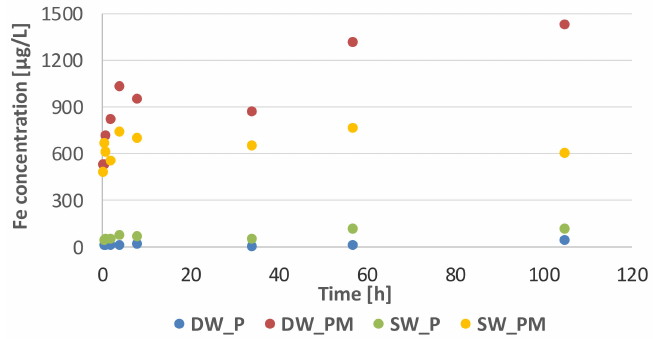
Figure 4. Changes in iron concentration in the tested solutions during the adsorption process. DW_P—deionized water enriched with phosphate, SW_P—e ffl uent from a sludge enriched with phosphate, DW_PM—deionized water enriched with phosphate and metal ions, SW_PM—e ffl